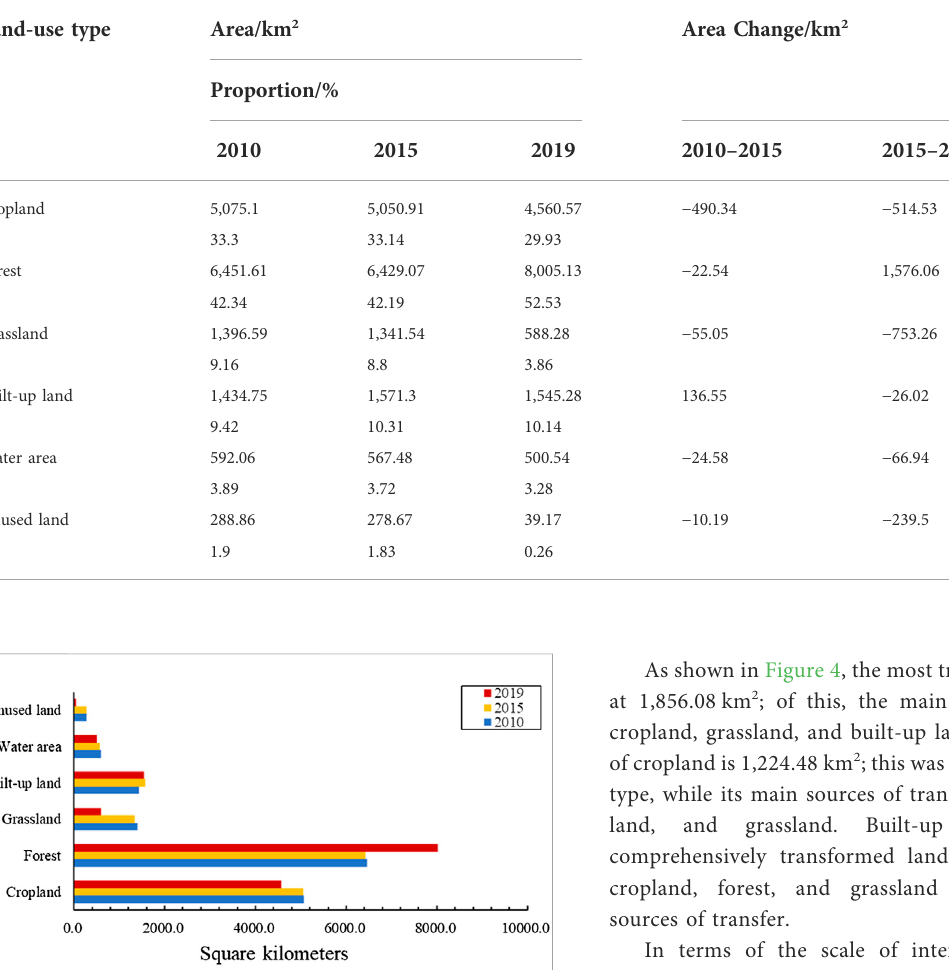
TABLE 2 LUCC patterns in Luoyang(km 2 ).